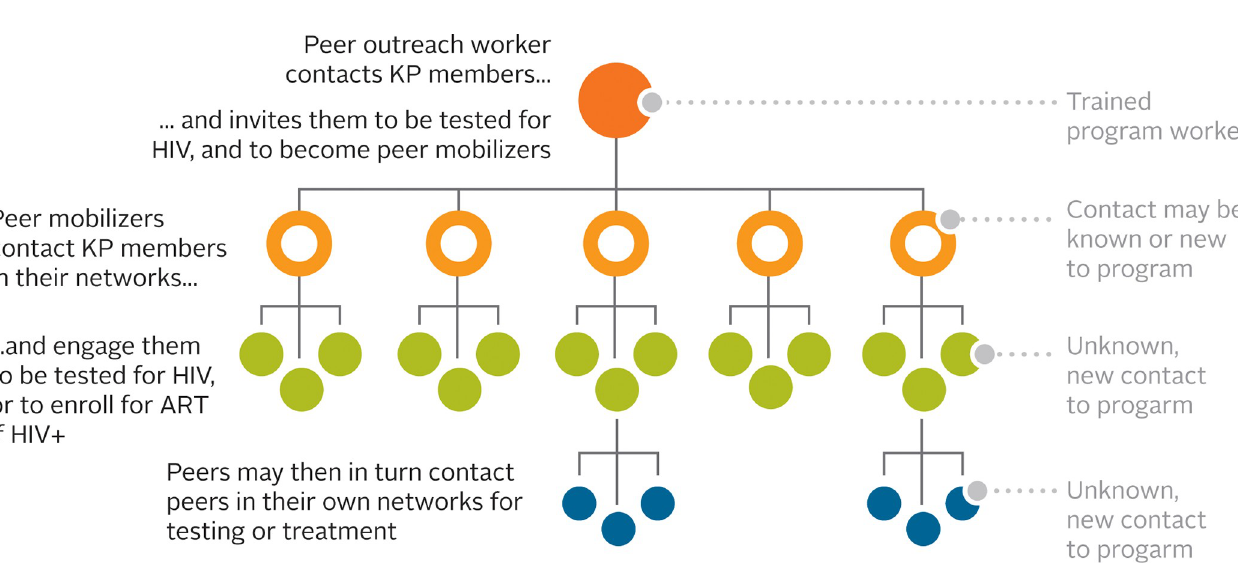
Fig 1. EPOA referral